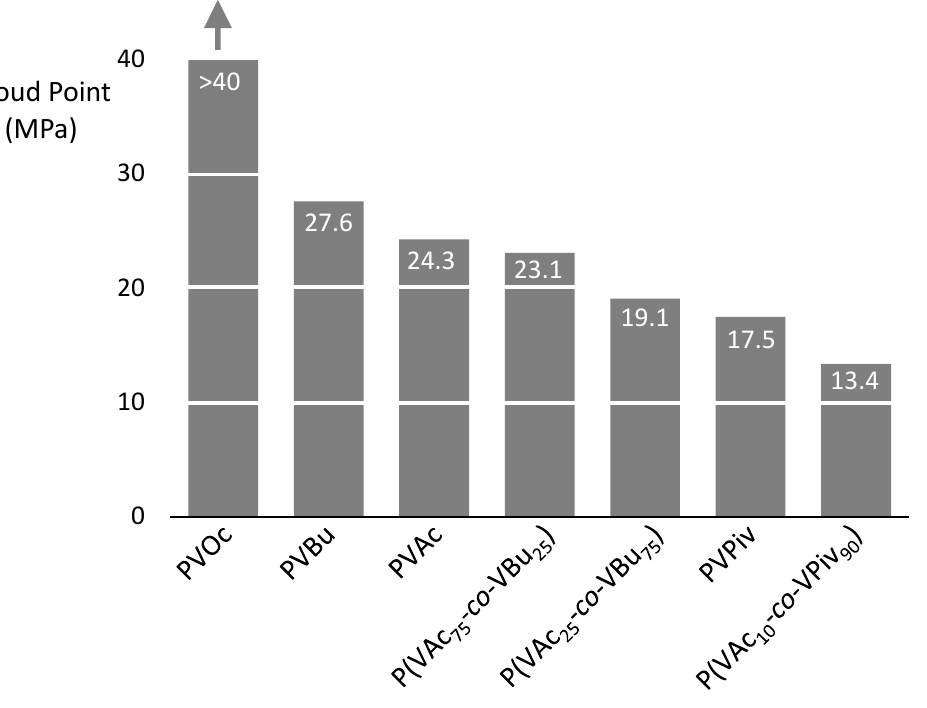
with PVAc, PVBu, PVOc and PVPiv, and 2 solubility with M near 10 2 n